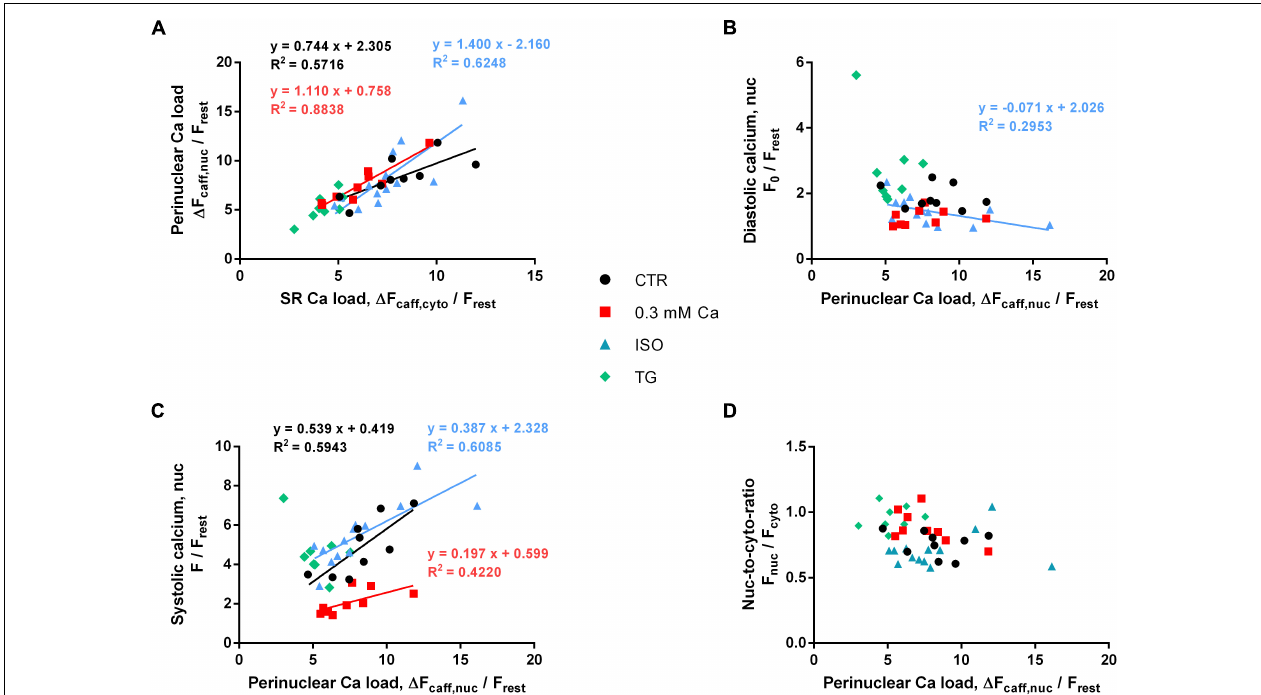
FIGURE 8 | Role of PN Ca load. (A) PN Ca load as a function of SR Ca load. Correlation analysis revealed positive correlation for CTR, 0.3 Ca and ISO groups with correlation coefficients r of 0.850 (CTR, black), 0.900 (0.3 Ca, red) and 0.841 (ISO, blue); all P < 0.001. For TG, correlation was not significant ( P = 0.069). Individual values from the three groups with positive correlation (black = CTR, red = Ca 0.3, blue = ISO) were fitted by a linear regression line (as indicated). (B) Diastolic Ca as a function of PN Ca load. Diastolic Ca did not correlate with PN Ca load (except for ISO; r = –0.632, P < 0.05). (C) Systolic Ca as a function of PN Ca load. Strong positive correlation was found for CTR, 0.3 Ca and ISO groups with correlation coefficients r of 0.733 (CTR, black, P < 0.05), 0.767 (0.3 Ca, red, P < 0.05) and 0.857 (ISO, blue, P < 0.001). Individual values from the three groups with positive correlation (black = CTR, red = Ca 0.3, blue = ISO) were fitted by a linear regression line (as indicated). (D) Systolic nuc-to-cyto ratio as a function of PN Ca load. No correlation between PN Ca load and systolic nuc-to-cyto ratio was found ( P = ns for all groups). Ca 0.3: n / N = 9/5, ISO: n / N = 13/4, TG: n / N = 8/2, CTR: n / N =